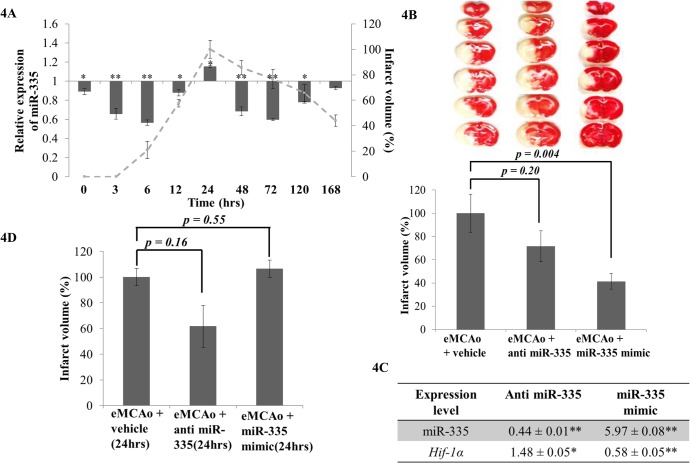
Effects of modulation of expression of miR-335 and Hif-1α mRNA in cerebral ischemia.
(A) miR-335 expression upon cerebral ischemia was measured at 0, 3, 6, 12, 24, 48, 72, 120 and 168 hrs by realtime PCR and relative expression is presented in the graph as a histogram (mean ± SD with n = 3). Infarct volume was plotted as the percentage of infarct volume at 24 hrs (maximum infarct volume) at each time point after eMCAo (—). The primary y-axis denotes relative expression of miR-335 whereas the secondary y-axis signifies the infarct volume; (B) TTC was used to stain coronal brain sections (2 mm thick) of rats injected with 50 pmoles of anti miR-335 or miR-335 mimic after eMCAo. Intracerebroventricular (ICV) injections were administered immediately following embolus introduction. Surviving cells were stained in pink while dead cells remained white. Infarct volume of treated rats were expressed as a percentage of the vehicle ± SEM, n = 4. (C)
Hif-1α mRNA expression significantly decreased in miR-335 mimic injection samples (p value < 0.01) whereas significantly increased when administration of anti miR-335. (D) ICV injections were administered at 24 hrs following embolus introduction. Infarct volume of rats treated with eMCAo + anti miR-335 or miR-335 mimic was expressed as a percentage of the vehicle ± SEM.